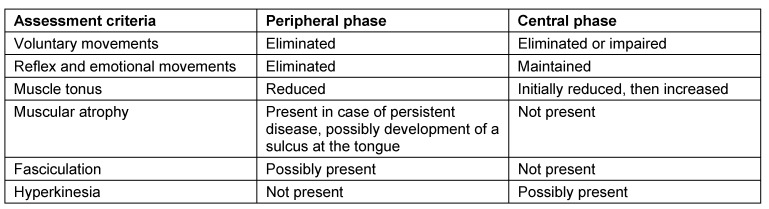
Differentiation of peripheral and central mobility disorders of the swallowing/speech organs